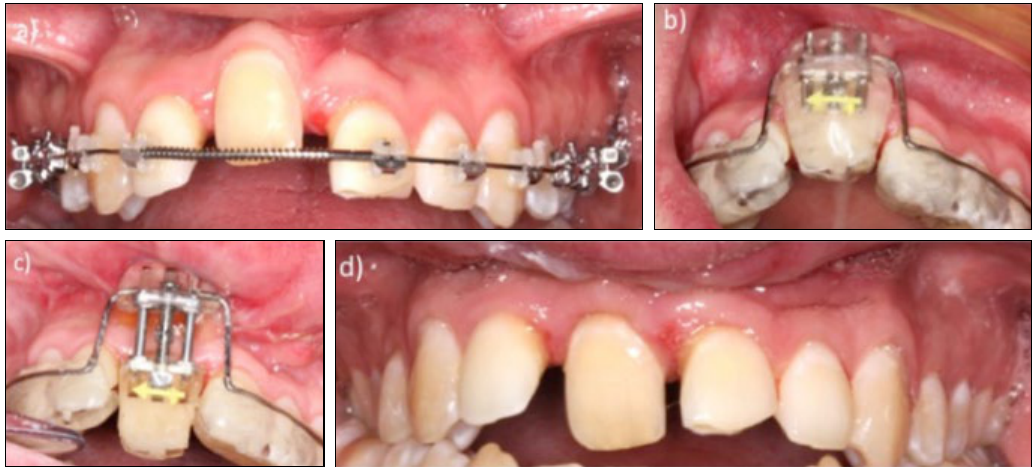
Figure 6. (a) pre-surgical orthodontic treatment; (b) with distraction appliance in place; (c) appliance after completion of distraction; (d) four weeks after surgery after deband of appliance.